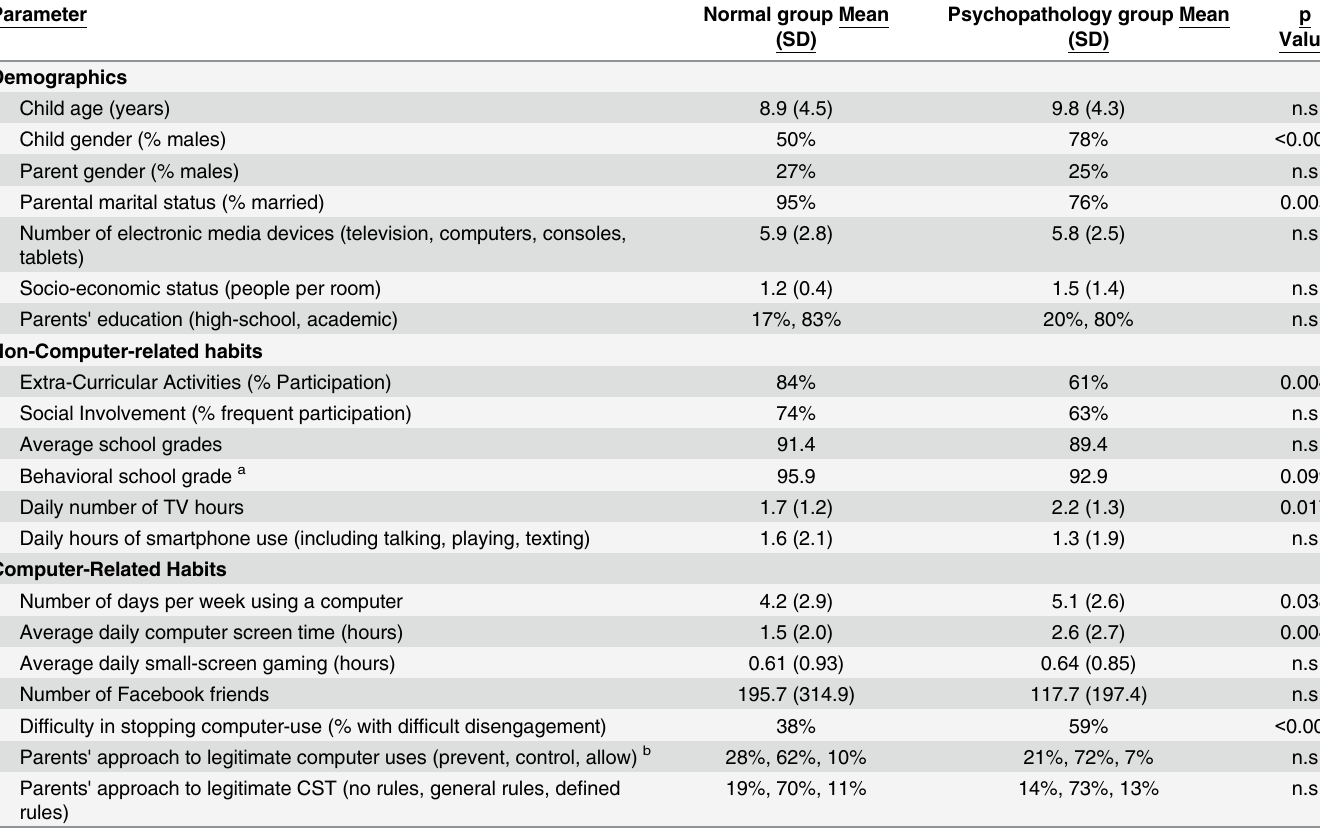
Table 1. Characteristics of the normal and psychopathology